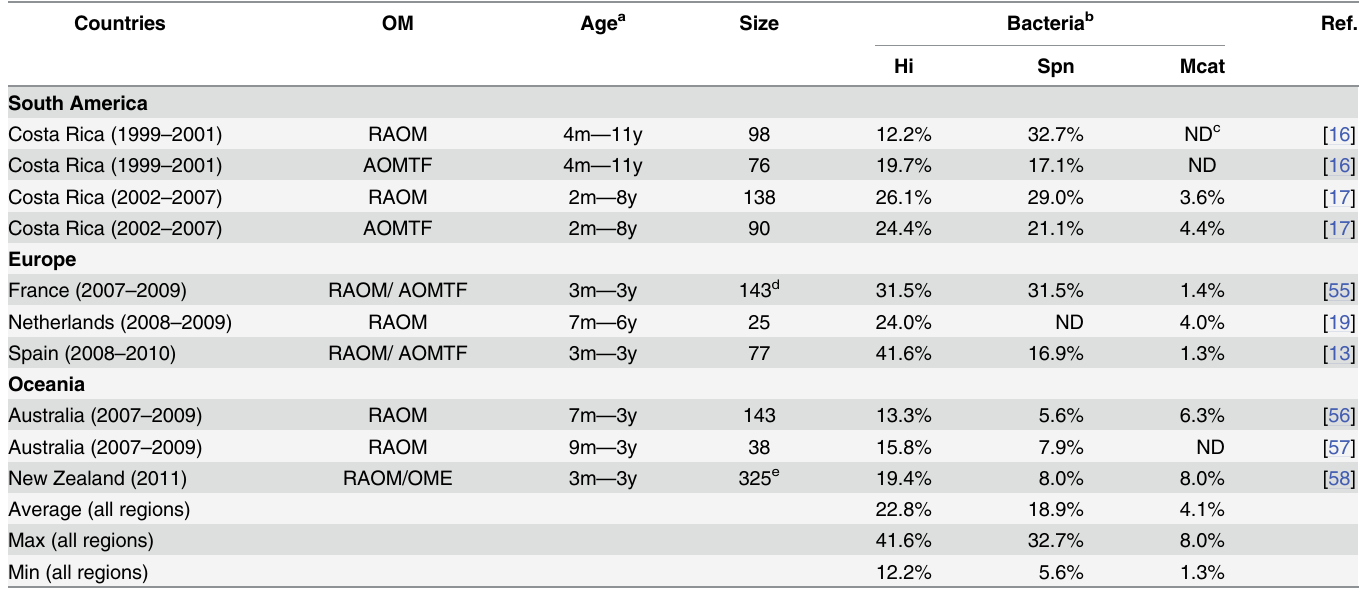
Table 2. S . pneumoniae , H . influenzae and M . catarrhalis detected from MEF of patients with